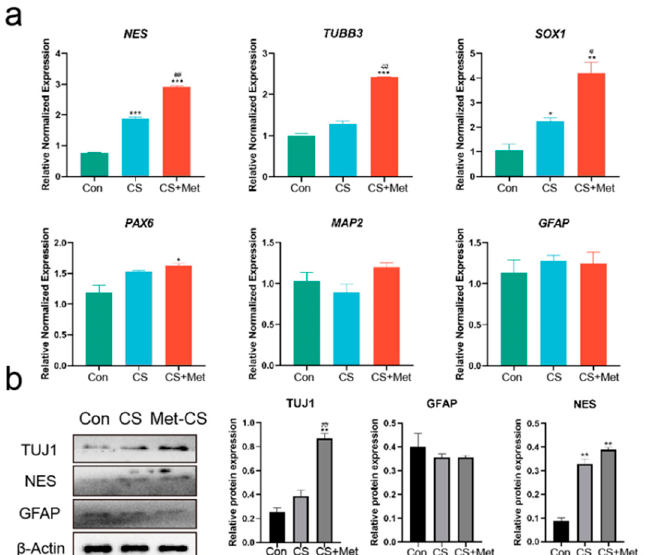
Figure 5. Protein and RNA expression of GMSCs related to nerve cells. ( a ) The mRNA expression levels of NES, TUBB3, SOX1, PAX6, MAP2, and GFAP under the culture conditions of Con group, CS group, and Met–CS group. ( b ) Under the three culture conditions, the protein expression levels of TUJ1, NES, and GFAP were displayed by Western blot, and the statistical graphs of the protein expression levels of TUJ1, NES, and GFAP were obtained from ImageJ. Scale bars: a, b = 10 μ m. Data are expressed as the mean ± SEM; n = 3, p < 0.05 *, p < 0.01 **, and p < 0.001 ***.